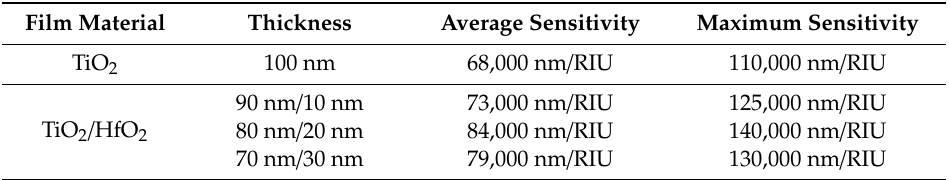
Table 1. Sensitivity comparison of the proposed sensor coated by metallic oxide bilayer with sensor coated by single TiO 2 layer.